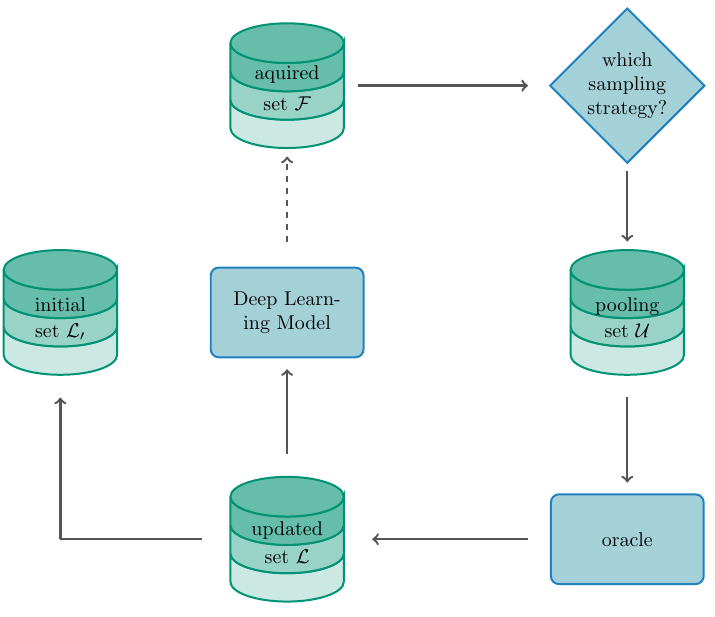
Figure 2. Visualisation of the active learning cycle for a DL